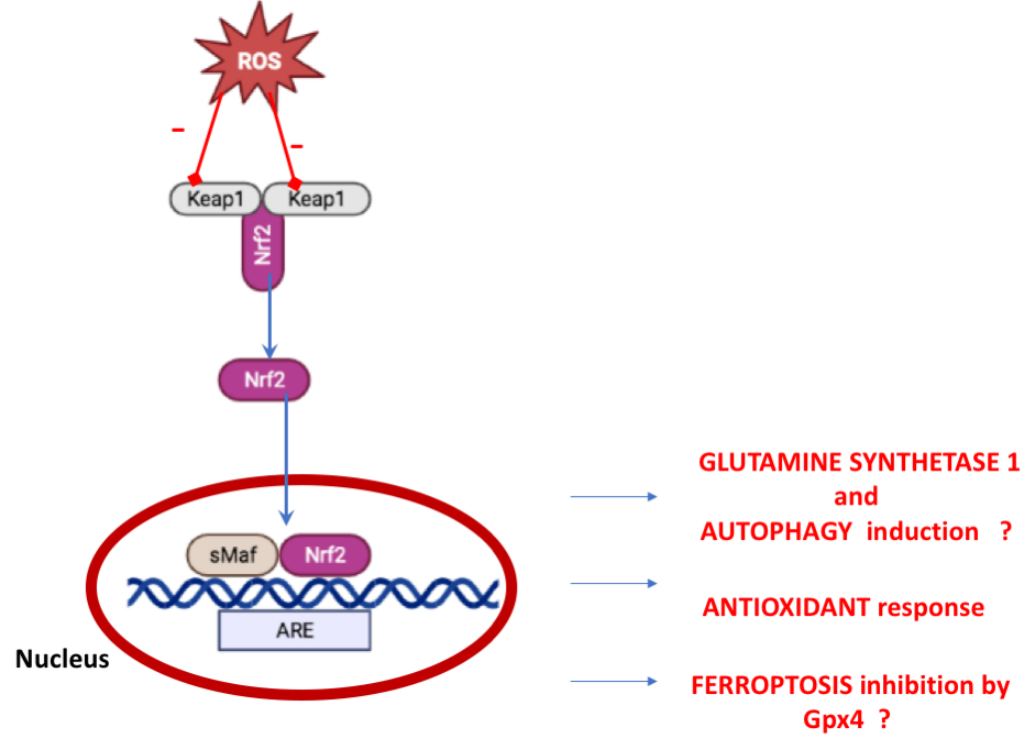
Figure 2. Keap1 – Nrf2 Pathway. The oxidative stress leading to Nrf2 nuclear translocation and antixiodant transcription (created in BioRender.com). ? indicates no demonstrated mechanism in neurodegenerative disorders. neurodegenerative